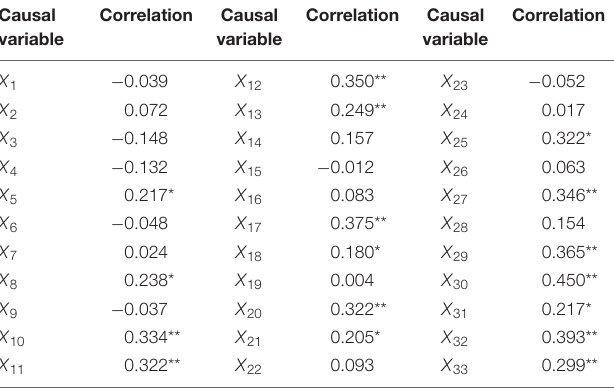
TABLE 4 | Correlation analysis.